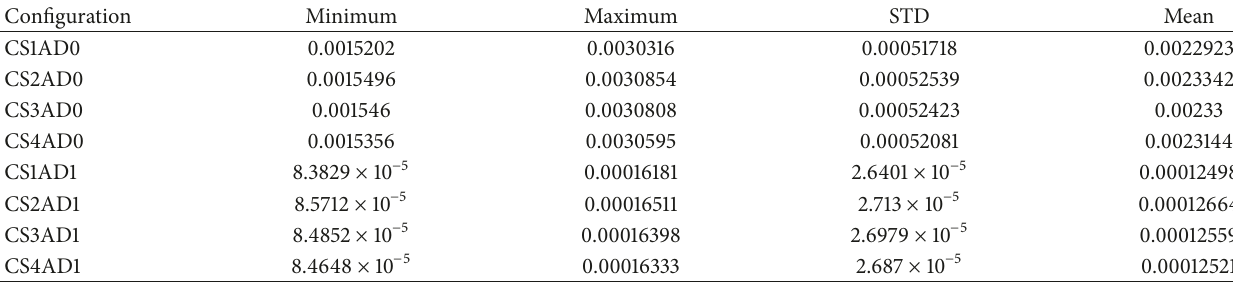
Table 7: Summary of statistical values of the results.